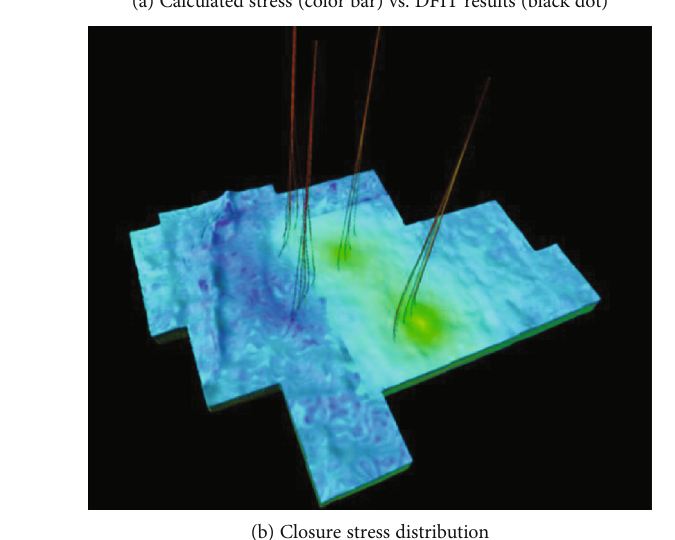
Figure 7: Veri fi cation of calculated closure stress and its distribution.